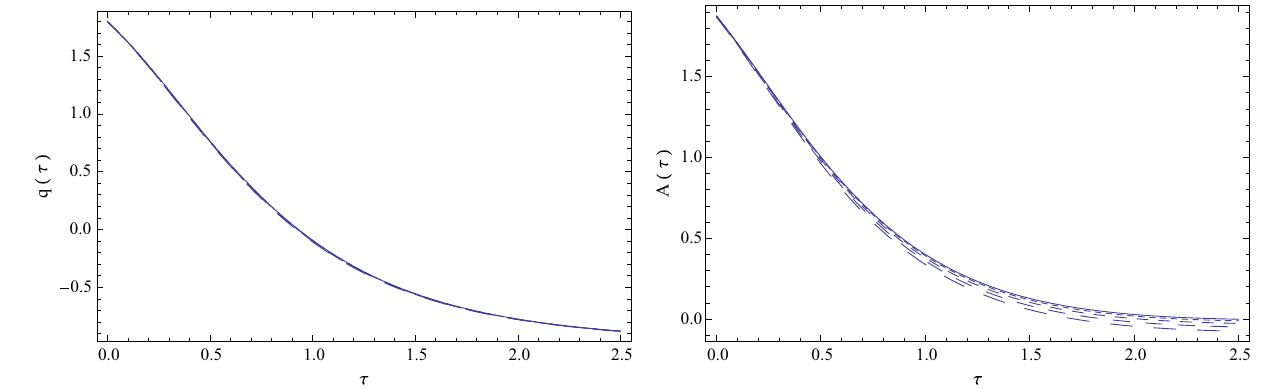
Fig. 4 Variation of the deceleration parameter q ( left figure ), and of the anisotropy parameter A ( right figure ) for a dust fluid filled Bianchi type I Universe in the Maxwell–Chern–Simons theory, for different val- ues of the parameter μ 0 : μ 0 = 0 . 10 ( solid curve ), μ 0 = 0 . 20, ( dotted curve ), μ 0 = 0 . 30, ( short dashed curve ), μ 0 = 0 . 40 ( dashed curve ), and μ 0 = 0 . 50 ( long dashed curve ), respectively. The initial conditions